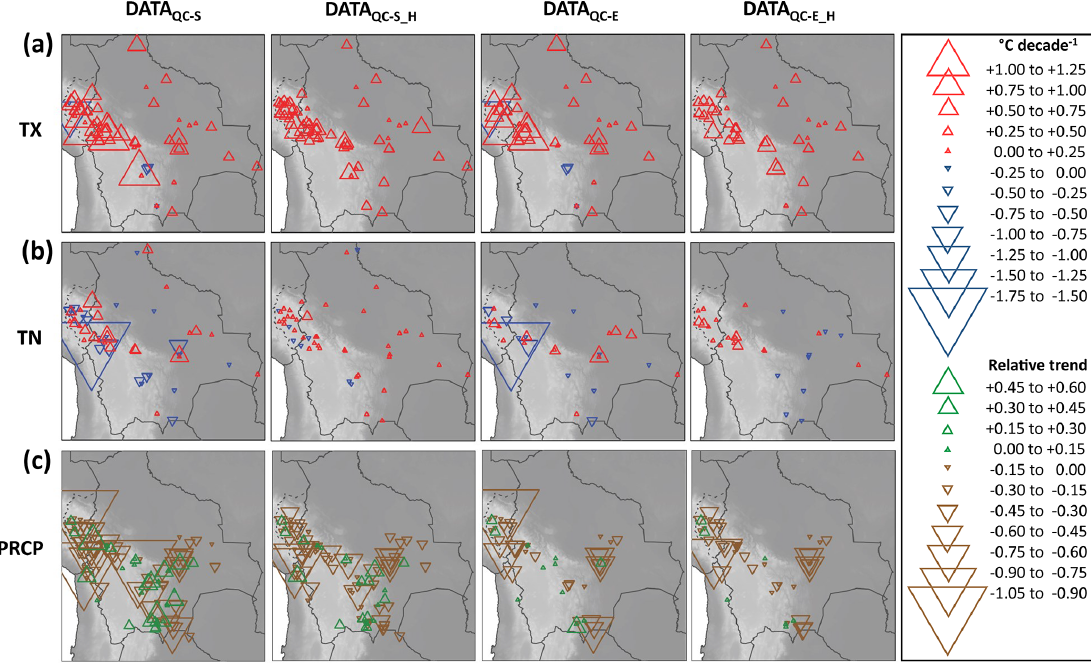
Figure 7. Trends of individual station records for maximum temperature (TX) (a) , minimum temperature (TN) (b) , and precipitation (PRCP) (c) from 1981 to 2010. The first column shows the results for the unhomogenized dataset quality controlled with the standard approach (DATA QC-S ), the second column shows the homogenized dataset quality controlled with the standard approach (DATA QC-S_H ), the third column shows the unhomogenized dataset quality controlled with the enhanced approach (DATA QC-E ), and the fourth column shows the homogenized dataset quality controlled with the enhanced approach (DATA QC-E_H ). For temperature, trends are indicated in ◦ C per decade. For PRCP, the relative magnitudes of the trend changes from 1981 to 2010 are shown. They are calculated from the difference between the fitted value at the end and the beginning of the time series, which is divided by the mean of the fit. A relative trend increase by 1 is equal to an increase by 200.0%, and a relative decrease by 1 is equal to a decrease by